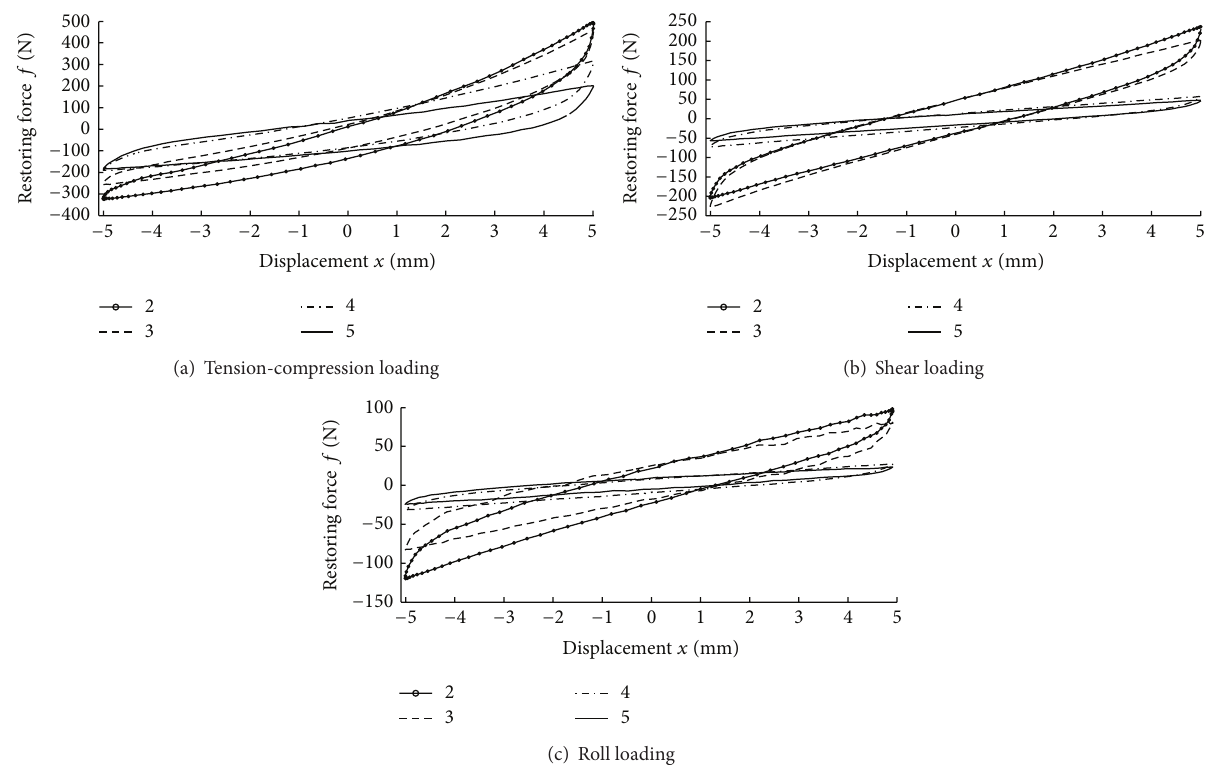
Figure 7: Experimental hysteresis loops of isolators with different wire rope loop